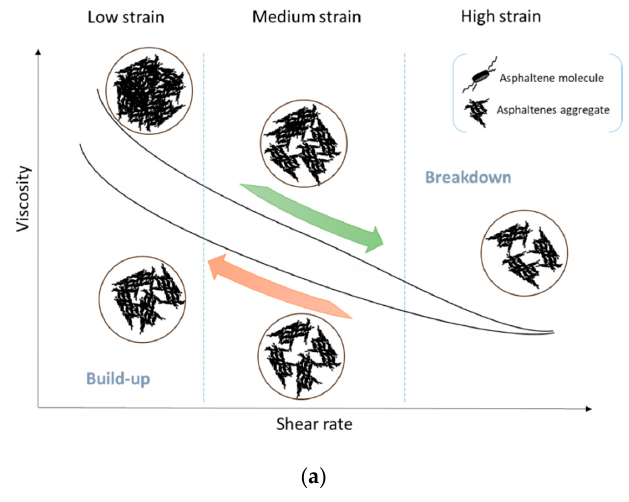
Figure 9. Cont. Figure 9.